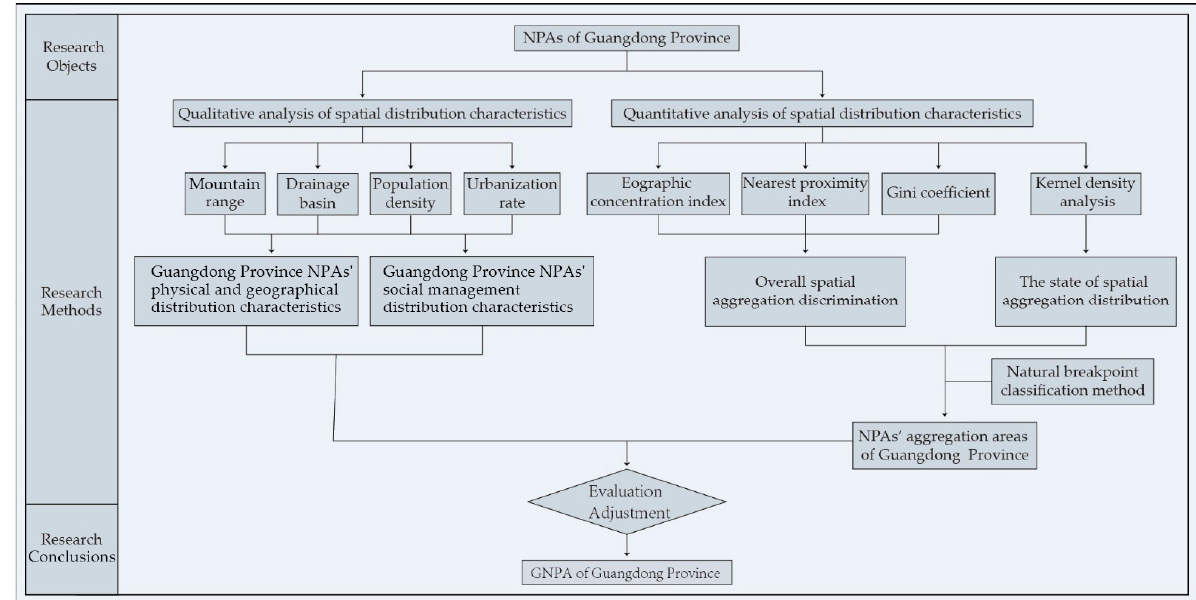
Figure 1. Research